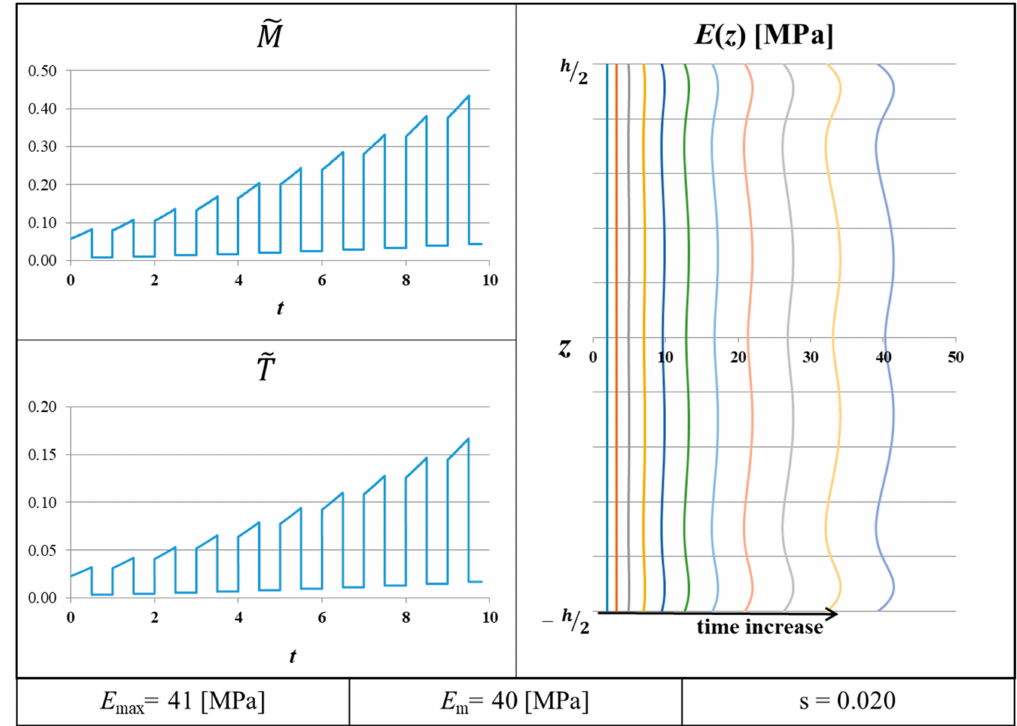
Figure 4. The intermittent loading program with 10% residual load and the resulting in-time Young’s modulus distribution along the height of the analyzed rectangular section, with the parameters of the